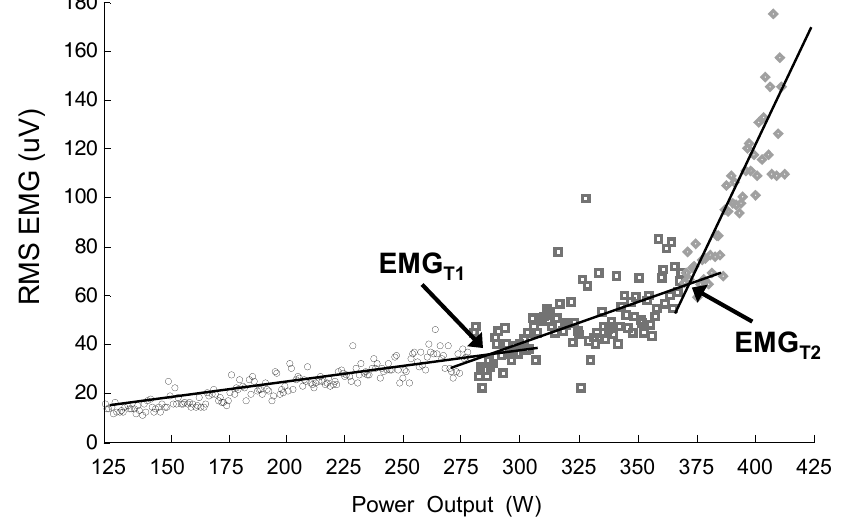
Figure 2. A representative example of a surface electromyographic (EMG) recording of the vastus lateralis obtained during the incremental test of one cyclist. Each data point represents the root mean square of the EMG (RMS EMG), obtained at two-second intervals. The RMS EMG data were fitted with three regression lines using the multi-segment linear regression method. The intersections between the regression lines mark the breakpoints in the linearity of the curve, thus yielding the first (EMG T1 ) and second (EMG T2 ) thresholds.